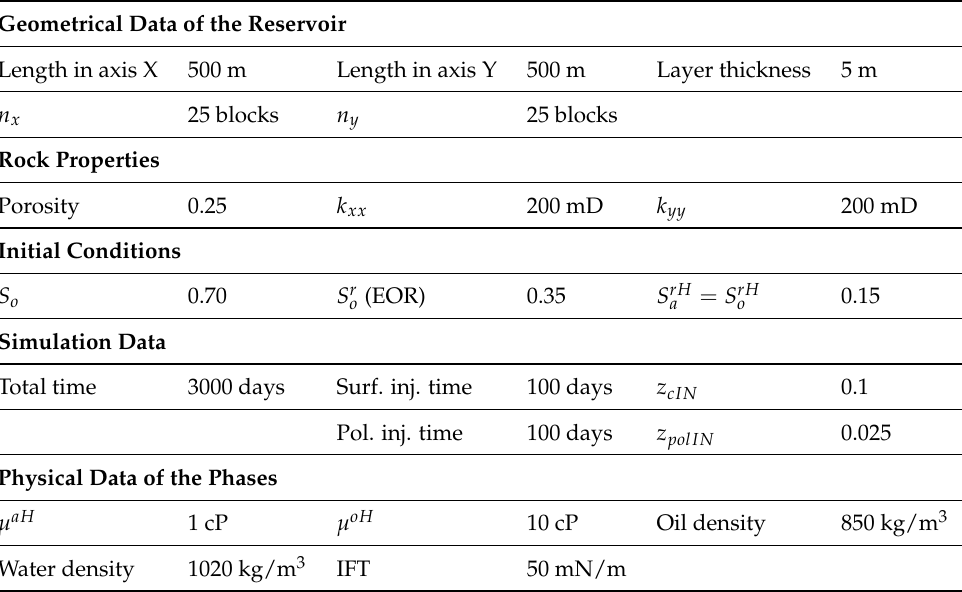
Table 1. General parameters (reproduced with permission from Druetta [28], Elsevier, 2017). Geometrical Data of the Reservoir